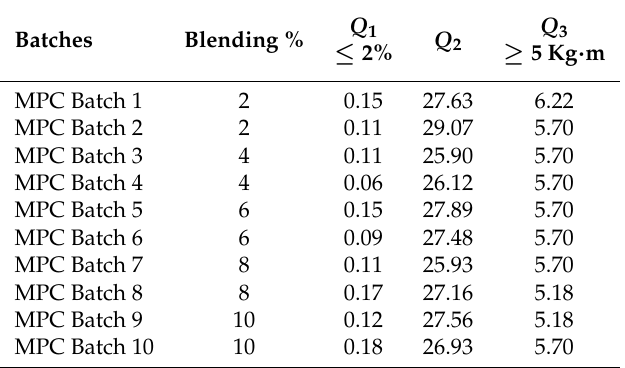
Table 4. Constrained case with varying